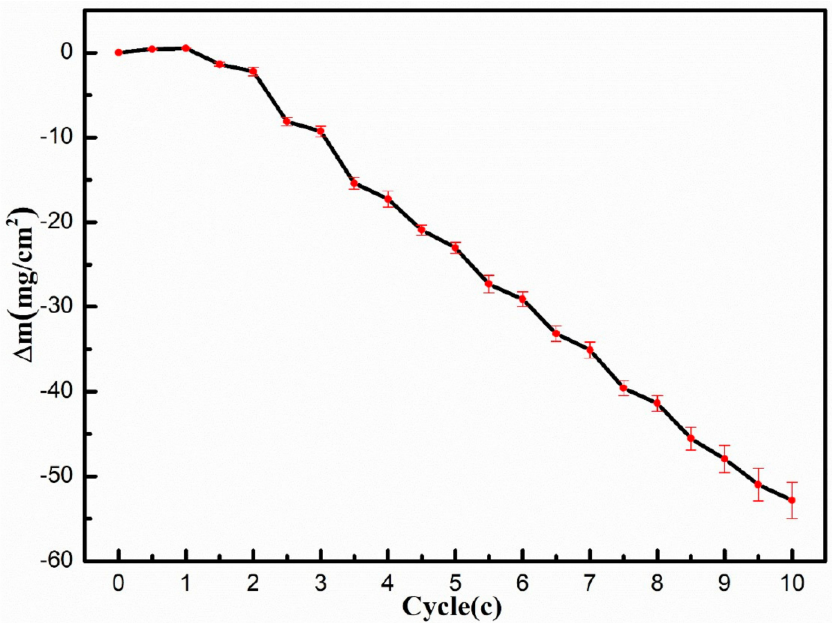
Figure 3. Weighing curve of GH4169 in 10 cycles of a high and low temperature alternating environment (oxidation at 900 ◦ C and emersion in 3.5% NaCl